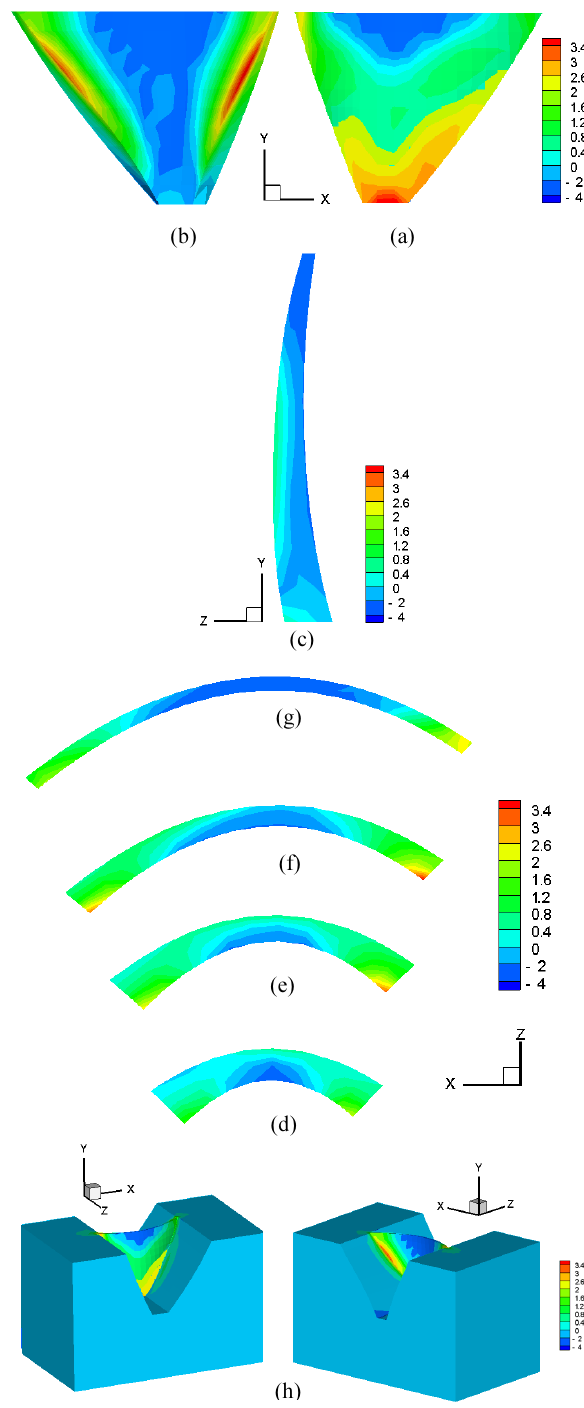
Fig. 7. Principal stress distribution (σ 1 ) at the end of dam const-